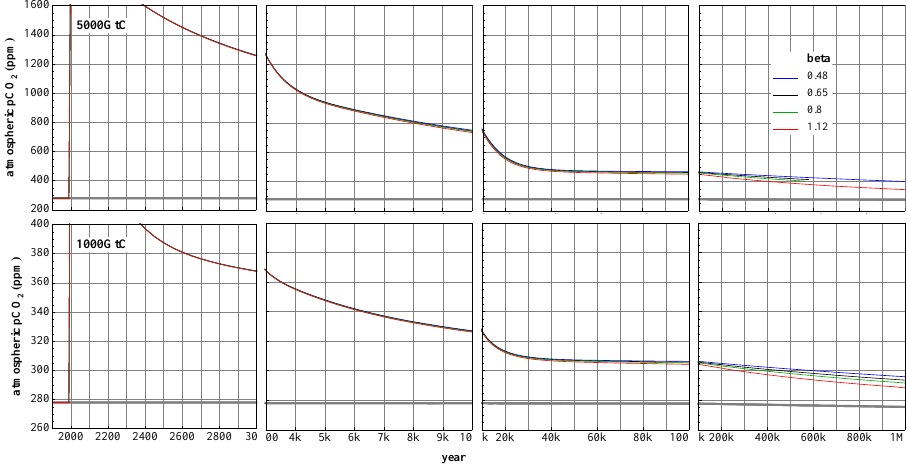
Fig. 10. Evolution of atmospheric CO 2 over 1Myr for 1000GtC (bottom) and 5000GtC (top) emissions pulses, vs. a control run with no emissions (grey lines), with carbonate and silicate weathering–run-off feedbacks (R_Ca and R_Si respectively) on/off and explicit/implicit (R_ex).